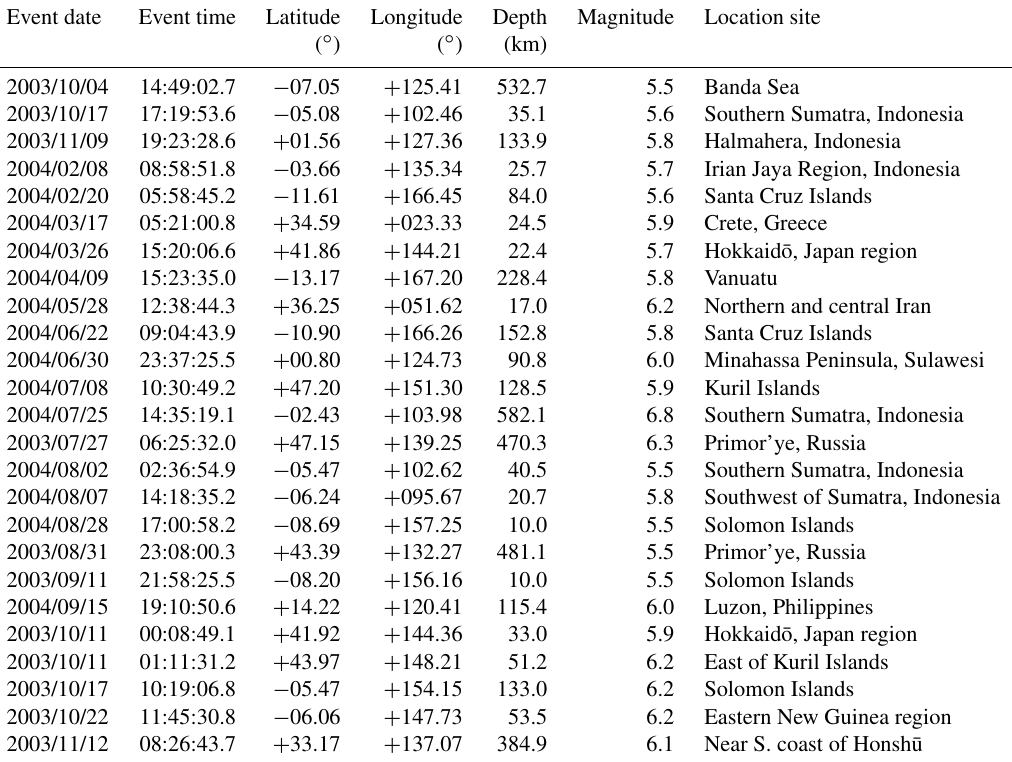
Table 1. List of the earthquakes used in this